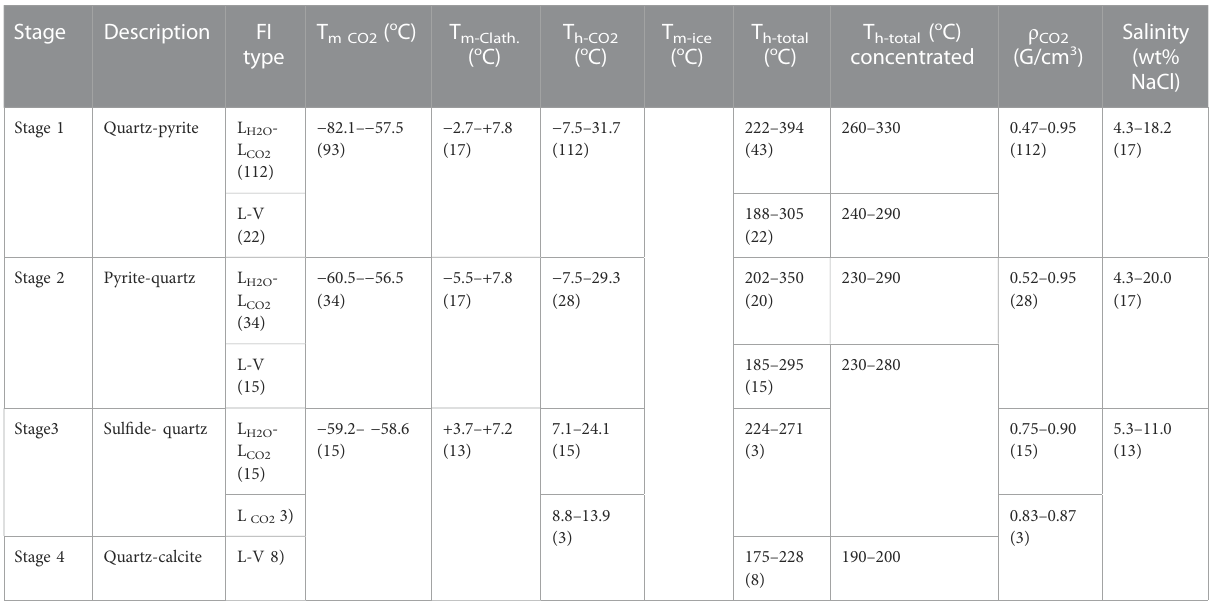
TABLE 2 Microthermometric results of fl uid inclusions from the Dongtongyu gold